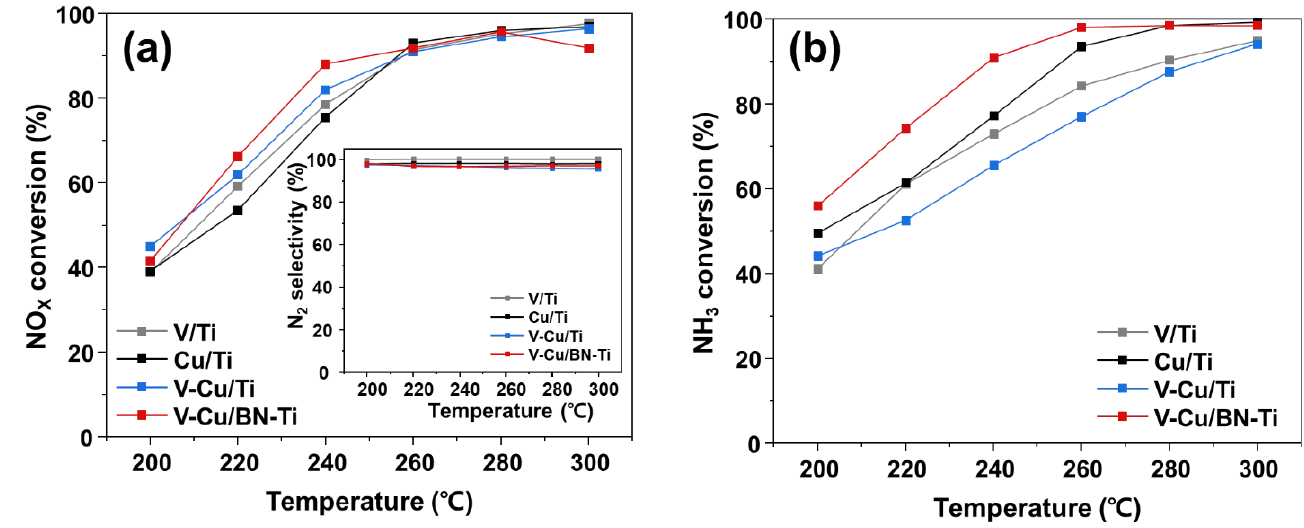
Figure 5. Catalytic performance of ( a ) NO X conversion (Inset: N 2 selectivity) and ( b ) NH 3 conversion of the synthesized catalysts. Gas condition were [NO X ] = [NH 3 ] = 300 ppm, [O 2 ] = 5 vol. %, [N 2 ] = balance, total flow = 500 mL/min and GHSV = 60,000 h − 1 . Evaluations performed under NH 3 /NO X = 1:1 revealed that V/Ti showed excellent